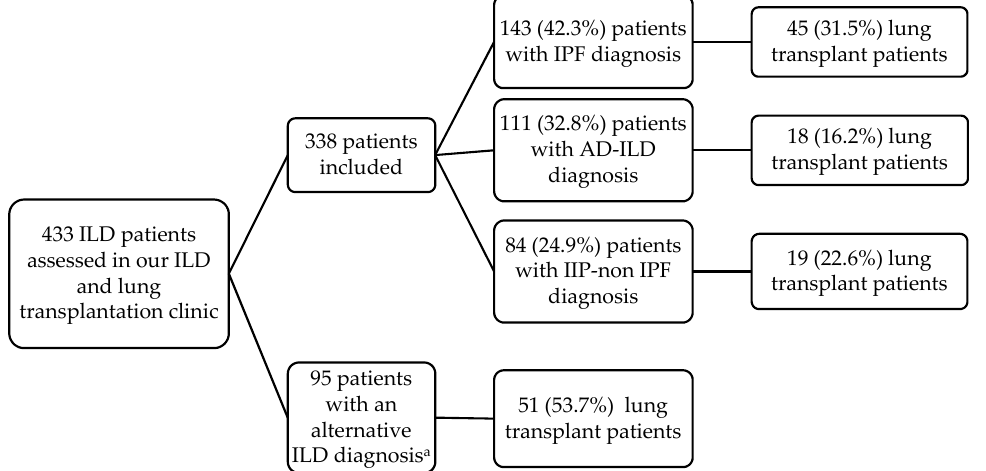
Figure 1. Flow diagram of patients’ assessment in our interstitial lung disease (ILD) and lung transplantation clinic. The term of “lung transplant patients” stands for patients actually transplanted